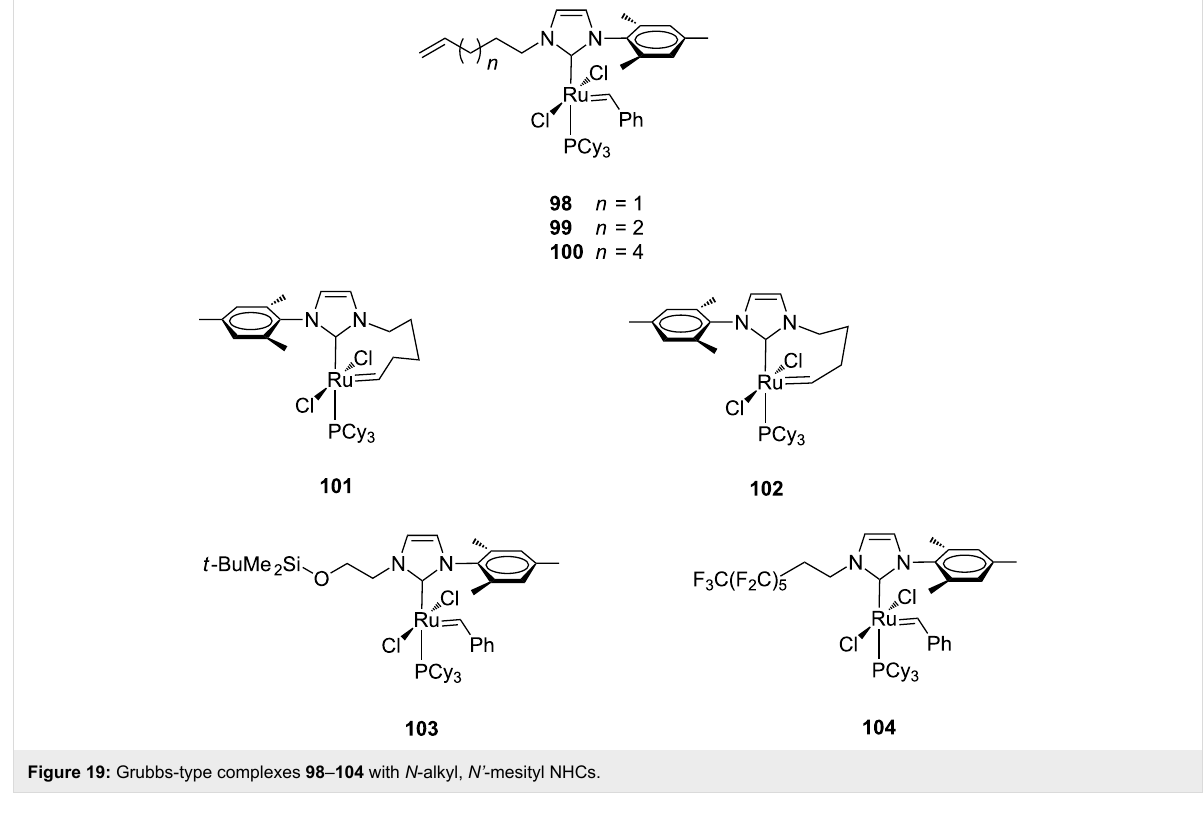
Figure 19: Grubbs-type complexes 98 – 104 with N -alkyl, N’ -mesityl NHCs.